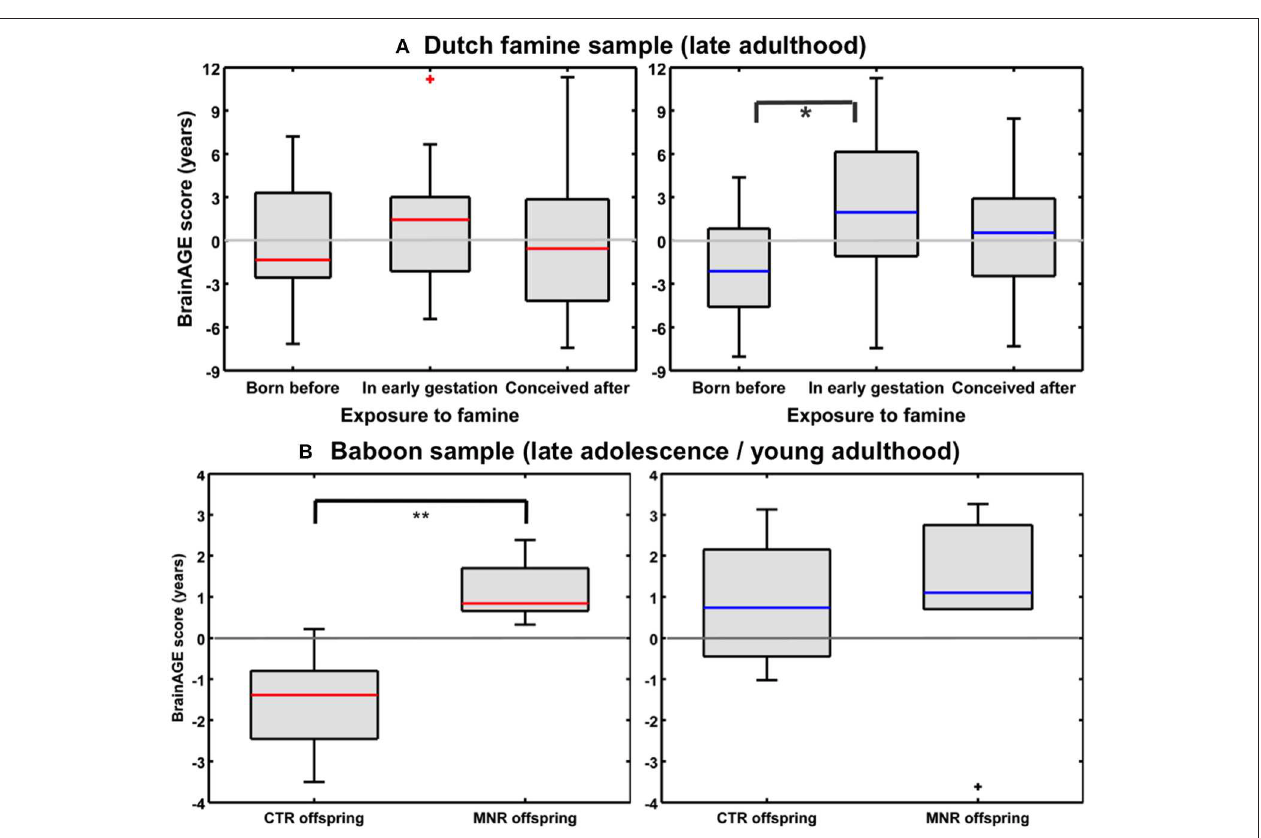
FIGURE 11 | Effects of prenatal undernutrition on brain aging. (A) Dutch famine sample: BrainAGE scores in late adulthood differed significantly between the three groups only in men (blue), but not in women (red). In men, post-hoc tests showed significantly increased scores in those with exposure to famine in early gestation (* p < 0.05). [Figure and legend reproduced from Franke et al. (85), with permission from Elsevier, Amsterdam.] (B) Baboon sample: BrainAGE scores in late adolescence/young adulthood differed significantly between female (red) CTR and offspring with maternal nutrient restriction (MNR) by 2.7 years (** p < 0.01), but not between male (blue) CTR and MNR offspring. [Figure and legend reproduced from Franke et al. (33), permitted under the Creative Commons Attribution License].